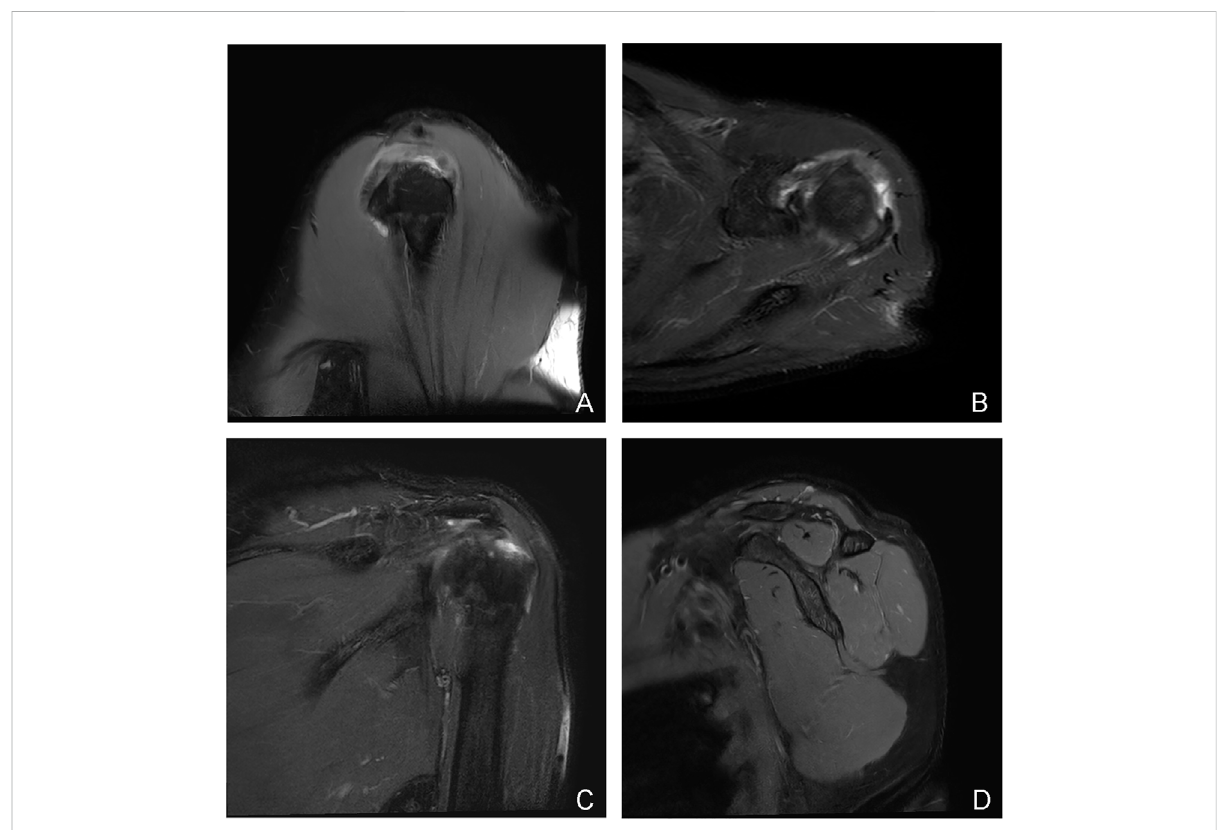
FIGURE 3 Atypicalcaseofcrescent-shapedtear:a51-year-oldmanwitha “ crescent ” tearofthearticularrimtendonintheleftshoulder,attheinsertionof theposteriorandanteriortuberositiesofthesupraspinatusandinfraspinatus (A – C) . (A) theobliquesagittallayerofT2lipid-suppressedsequence; (B) the axial layer of proton density sequence; (C) the oblique coronal layer of T2 lipid-suppressed sequence; (D) the oblique sagittal layer of the rotator cuff Y-view of the T2 fat-suppressed sequence, showing the normal shape and signal of the four muscles that make up the rotator